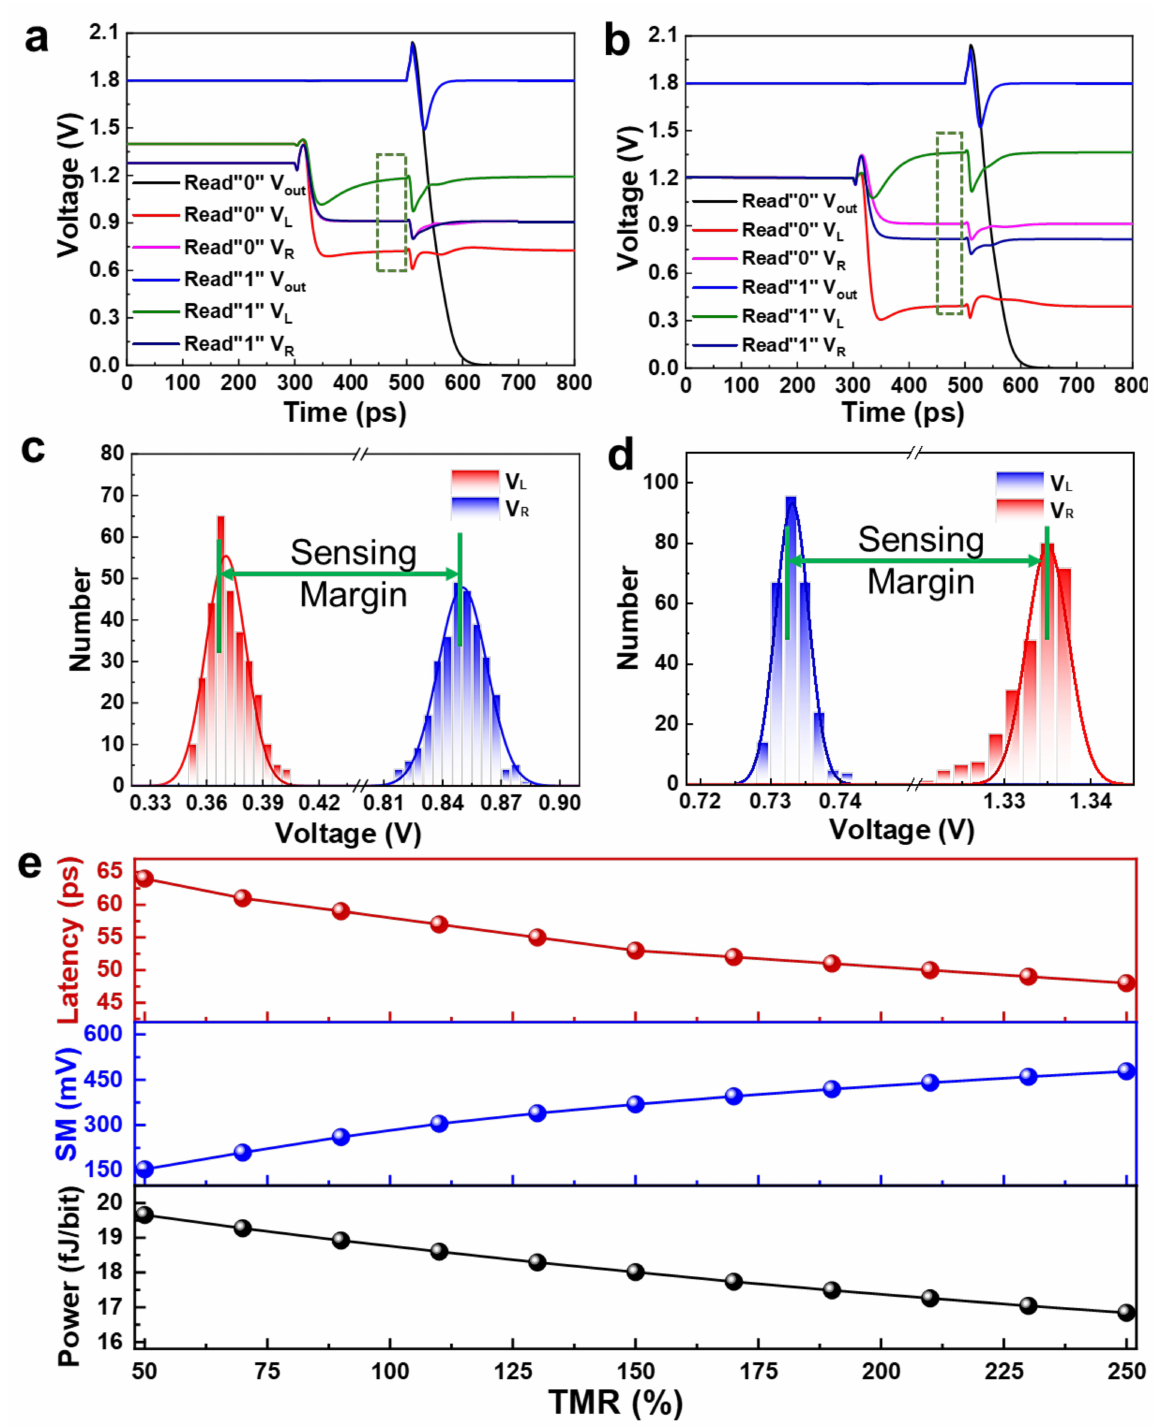
Figure 6. The reading performance of 2T1M and 3T2M SOT-MRAM. ( a ) The 2T1M and ( b ) 3T2M SOT-MRAM read result, “1” (blue) and “0” (black), respectively. The dynamic process of their branch voltage V L and V R . The red dash frames show the SM, respectively. ( c , d ) The Monte Carlo simulation result of V L and V R in reading “0” ( c ) and “1” ( d ) of 3T2M SOT-MRAM. € The TMR of MTJ effects on latency (upper panel), SM (middle panel), and power consumption (lower panel) in the reading process of a 3T2M cell. ( e ) Impact of TMR on the reading performance of 3T2M structure. Delay, reading margin, and power consumption of the device are all important para- metric indexes, and the TMR of the MTJ bear an important impact on the above